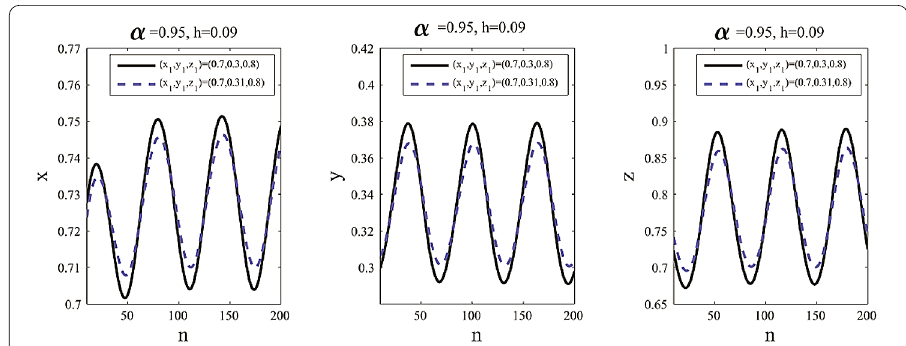
Figure 2 Phase portraits of model (4).